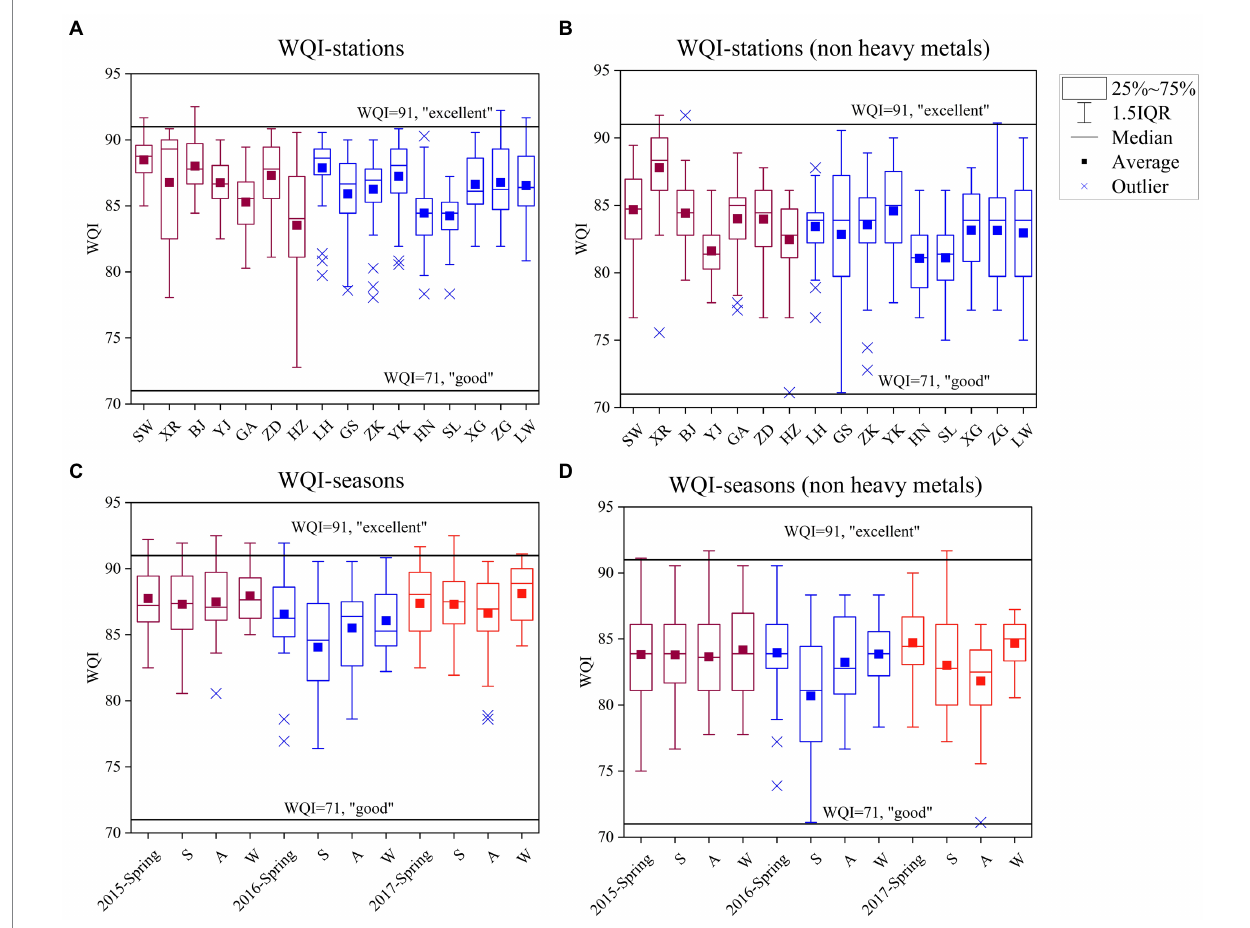
FIGURE 6 Evaluation of water quality using the WQI methods in the HJR during the year 2015 to 2017: (A) WQI-stations, (B) WQI-stations without heavy metals, (C) WQI-seasons, (D) WQI-seasons without heavy